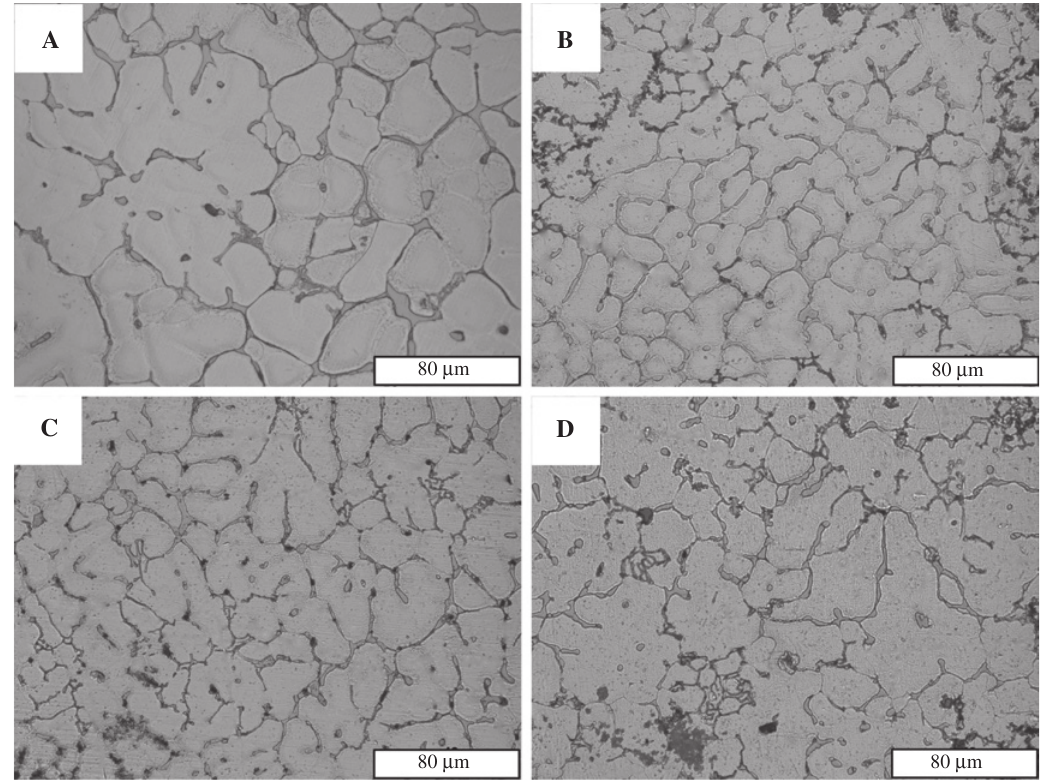
/Al2014 composites with different particle contents: (A) 0, (B) 0.5 vol.%, (C) 1 vol.%, p